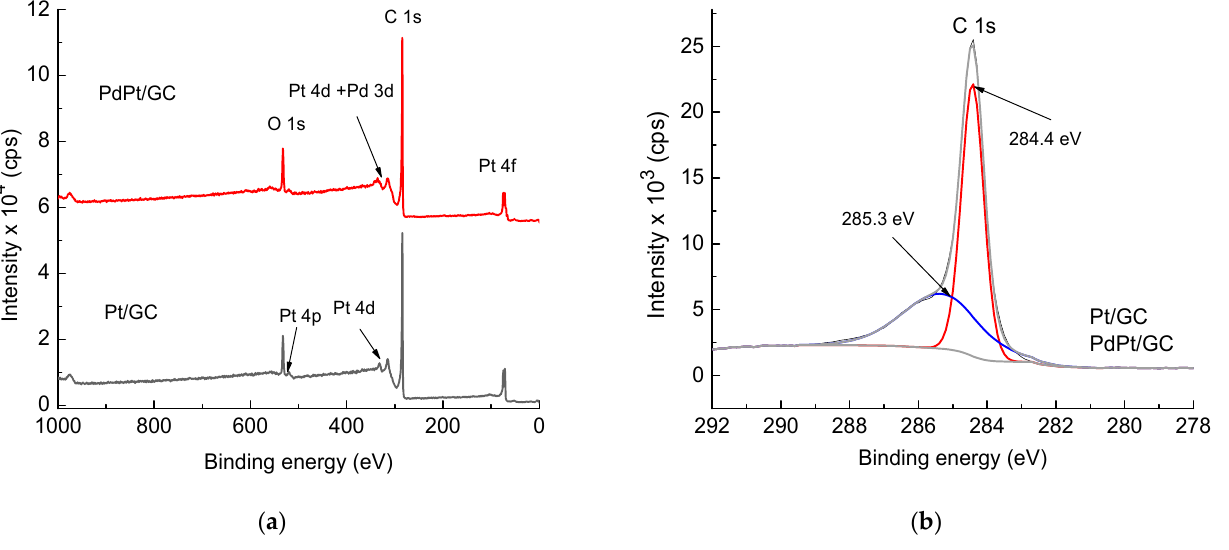
Figure 3. XPS spectra of Pt/GC and PdPt/GC: ( a ) Survey spectra; ( b ) High-resolution spectrum of C 1s line characteristic for both electrodes. 1s line characteristic for both